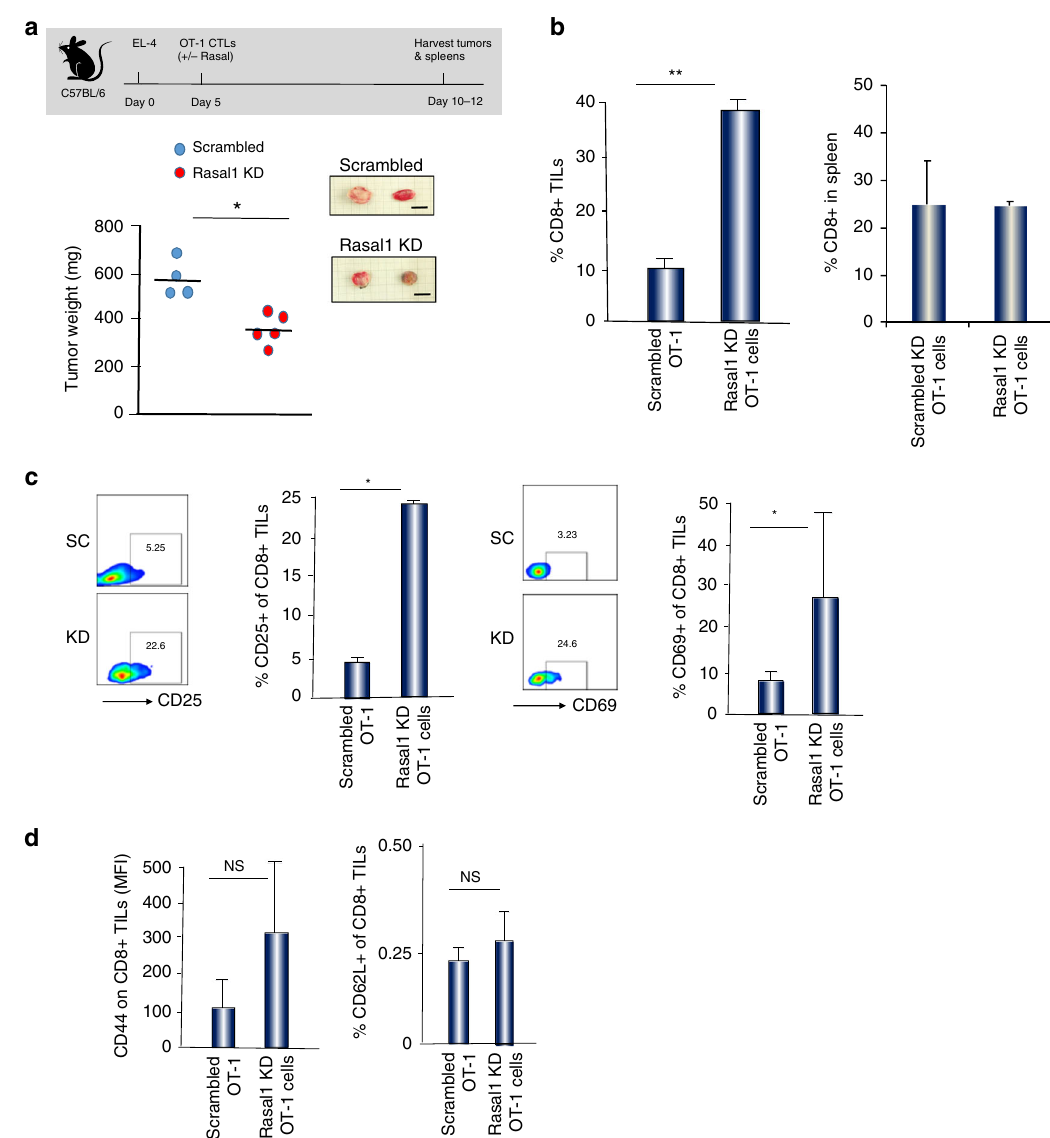
Fig. 8 Rasal1 KD T cells show reduced EL-4 tumor size concurrent with an increase in the presence of activated CD8 + TILs. a Upper panel: schematic of EL4 solid tumor experiment. Lower panel: quanti fi cation of tumor size in mice receiving OT-1 cells expressing control scrambled siRNA or Rasal1 KD siRNA T cells ( n = 4 per group, lower panel). Upper inset panel shows representative images of some EL4 tumors from each group (scale bar, 5 mm). b Histogram showing an increase in the percentage of CD8 + TILs in mice injected with CD8 + Rasal1 KD relative to scrambled siRNA T cells (left panel). No increase was seen in the spleens of these mice (right panel). c Histograms showing an increase in the expression of CD25 and CD69 on CD8 + TILs from mice injected with control scrambled siRNA or with Rasal1 KD siRNA T cells. d Histograms showing the MFI values for CD44 expression (left panel) and the percentage of CD62L-positive CD8 TILs (right panel) from mice injected with scrambled siRNA or Rasal1 KD siRNA T